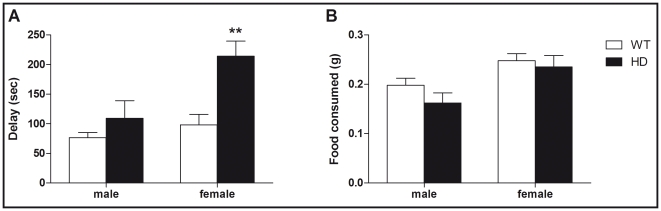
Effect of sex and HD mutation on the novelty suppressed feeding test (NSFT).(A) Analyzing the time (expressed in sec) to complete the task in the NSFT, we found a significant interaction between sex and genotype (F(1,55) = 4.2, p<0.05). Indeed compared to WT animals, only HD female mice exhibited greater delay to complete the NSFT. (B) Interestingly measuring the amount of food consumed after NSFT, we did not find any effect of genotype (F(1,55) = 1.7, p = 0.19) or interaction with the sex (F(1,55) = 0.39, p = 0.54). Values represent means (± SEM) of n = 12–17 mice per group. WT vs. HD: (***) p<0.001.